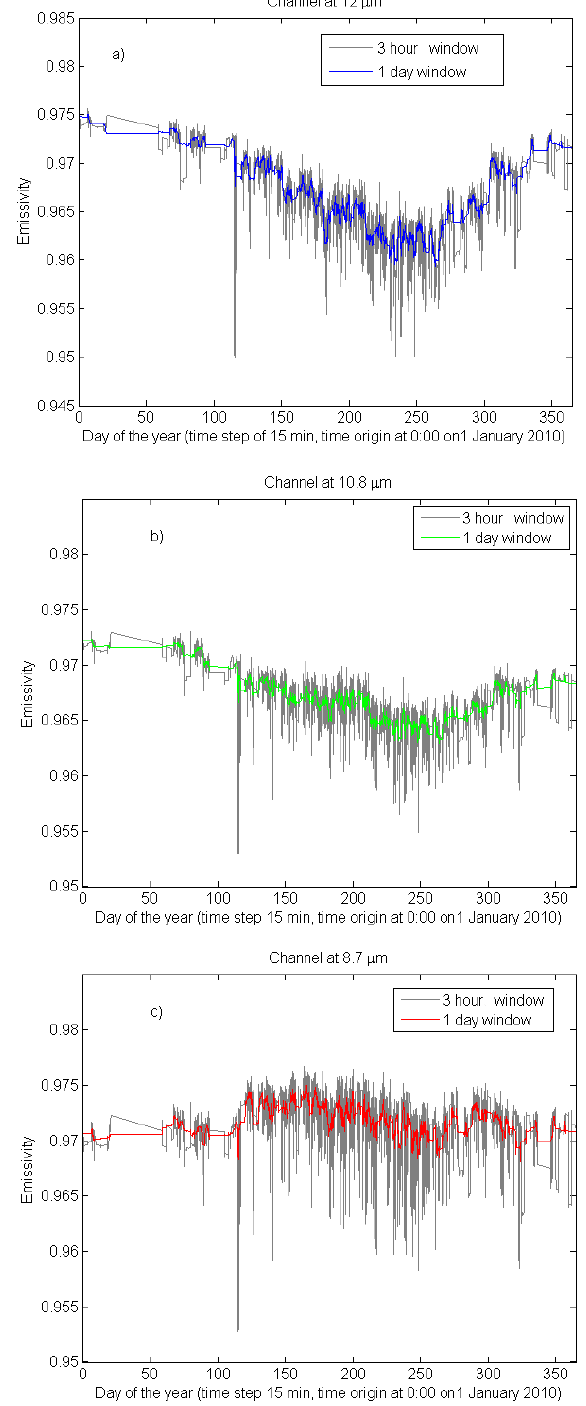
Figure 8. Emissivity retrieval for the Evora validation station. The retrieval has been smoothed with a moving-average filter with time windows of 3h and 1 day. Top panel, 12µm; middle panel, 10.8µm; bottom panel, 8.7µm. Retrievals refer to the year